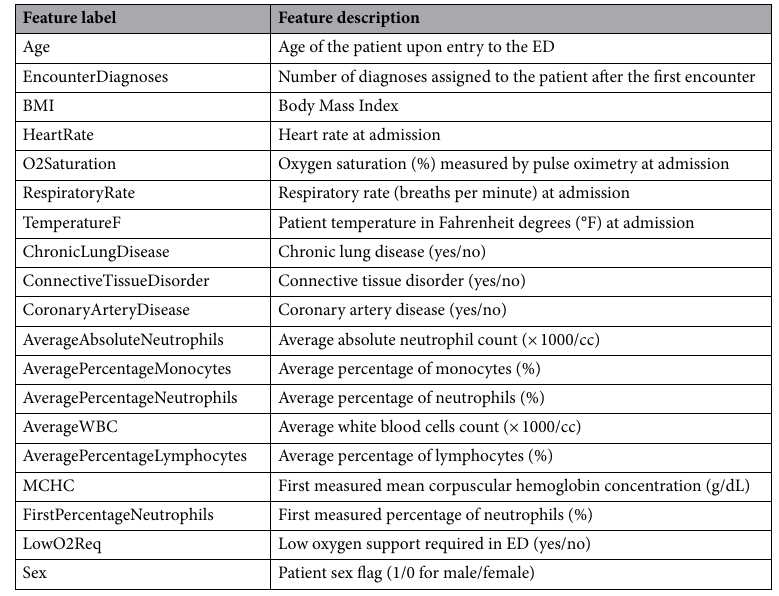
Table 1. Most important original features identified by XGBoost permutation feature importance algorithm.